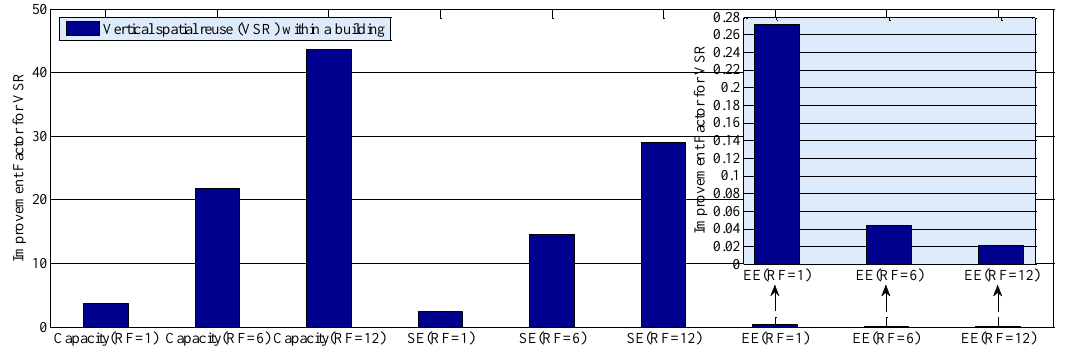
Figure 2. Performance improvement of the proposed technique over the traditional static licensed spectrum access (SLSA) technique due to the variation in spatial reuse factor (RF) vertically within a building, in terms of average capacity, spectral efficiency (SE), and energy efficiency (EE).